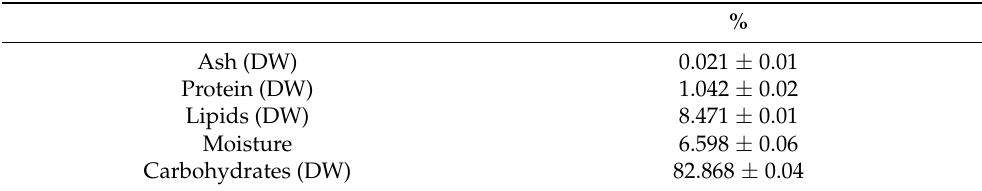
Table 1. Proximate analysis of the ASTRA